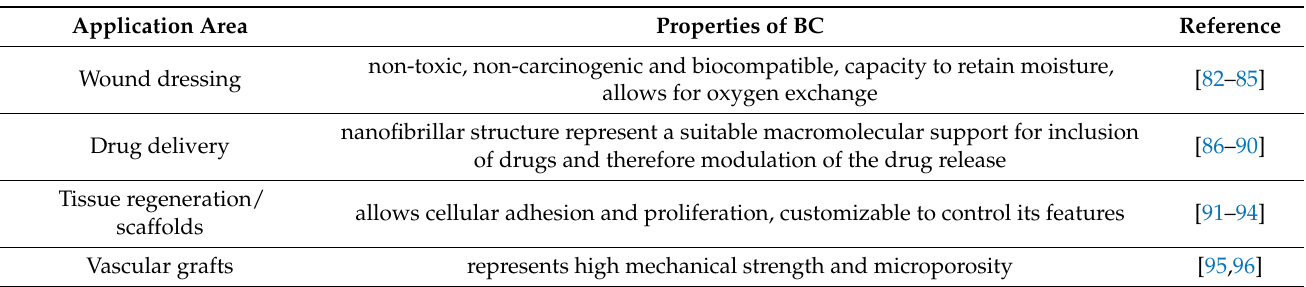
Table 2. Recent studies investigating the potential of BC in biomedical applications. Application Area Properties of BC